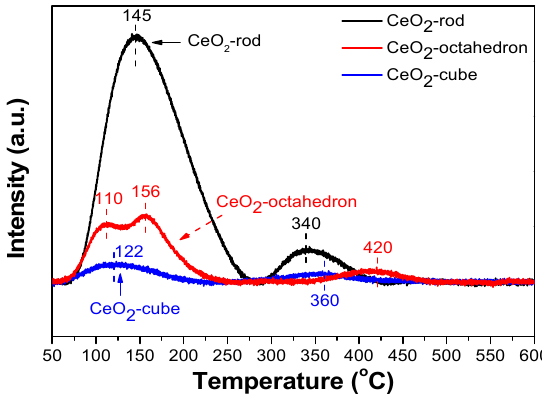
Figure 3. NH 3 -TPD of CeO 2 with different morphologies.